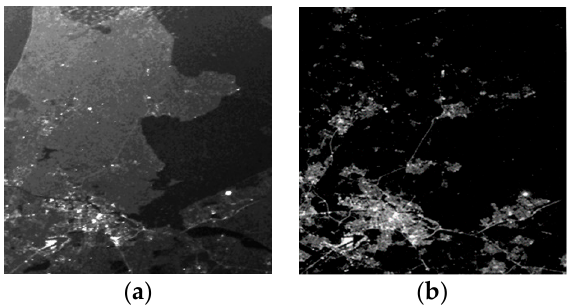
( c ) Figure 15. Different frames of nighttime image of the Moscow area (55 ° N), acquired when satellite was illuminated by sun on 21 June 2018. ( a ) Solar incident angel is 57°; ( b ) solar incident angel is 52°; ( c ) solar incident angel to optical is 47°. It is worth noting that, there is another phenomenon for nighttime imagers, which seems like the stray light influence, but it is totally different. It is caused by the practical illumination situation variations of the observed scene, so it can hardly be reduced by any hardware solution. An example is shown in Figure 16. These two images demonstrate the same area near Amsterdam in different seasons. When Figure 16a was acquired on 29 June 2018, the solar elevation angle for this area is nearly zero, hence the land and clouds were illuminated by sun and would reflect some sunlight towards the camera. Compared with Figure 16b, which was acquired on 7 September 2018, the terrestrial boundary on Figure 16a was much clearer. Obviously, although for Figure 16a with the satellite illuminated by sun, increase of the grayscale number on the image was not simply caused by solar stray light effects on the camera. The image just recorded the real scene as any camera can see at that time. This is quite different from the example given in Figure 15. As Figure 16a was acquired when sun illuminated on satellite, it was also evidence for the camera’s good stray light reduction performance, because the artificial lights can also be detected on the image with no evident of stray light pollution. However, for end users who want to